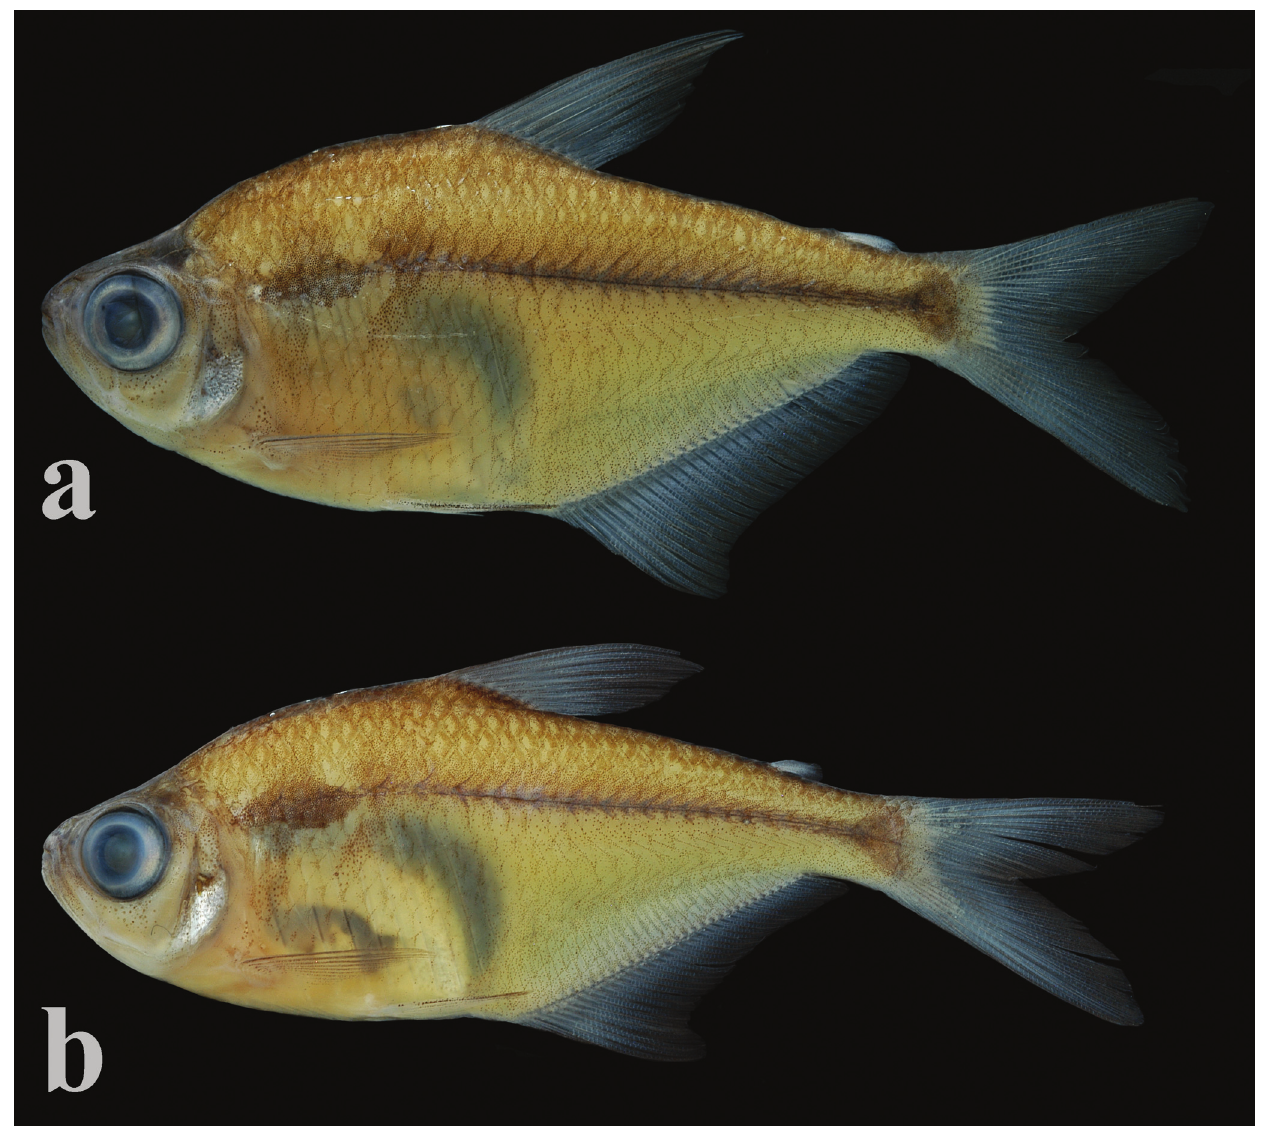
Fig. 2. Moenkhausia doceana , MBML 3831, (a) male, 68.9 mm SL, and (b) female, 62.7 mm